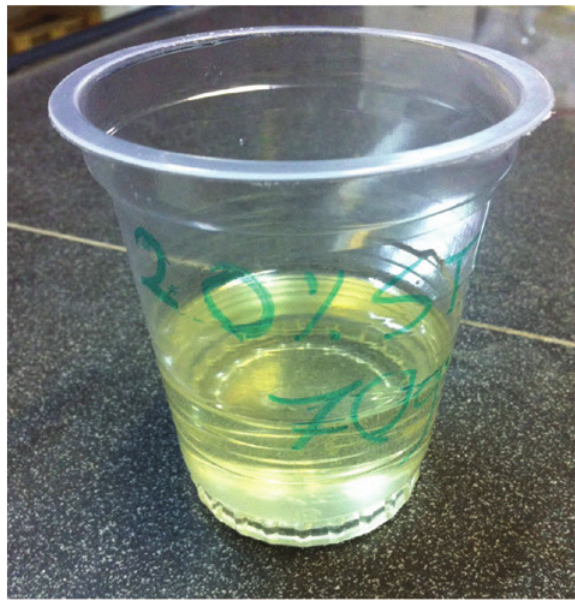
Figure 3: Shear thickening fluid made by PEG and the silica